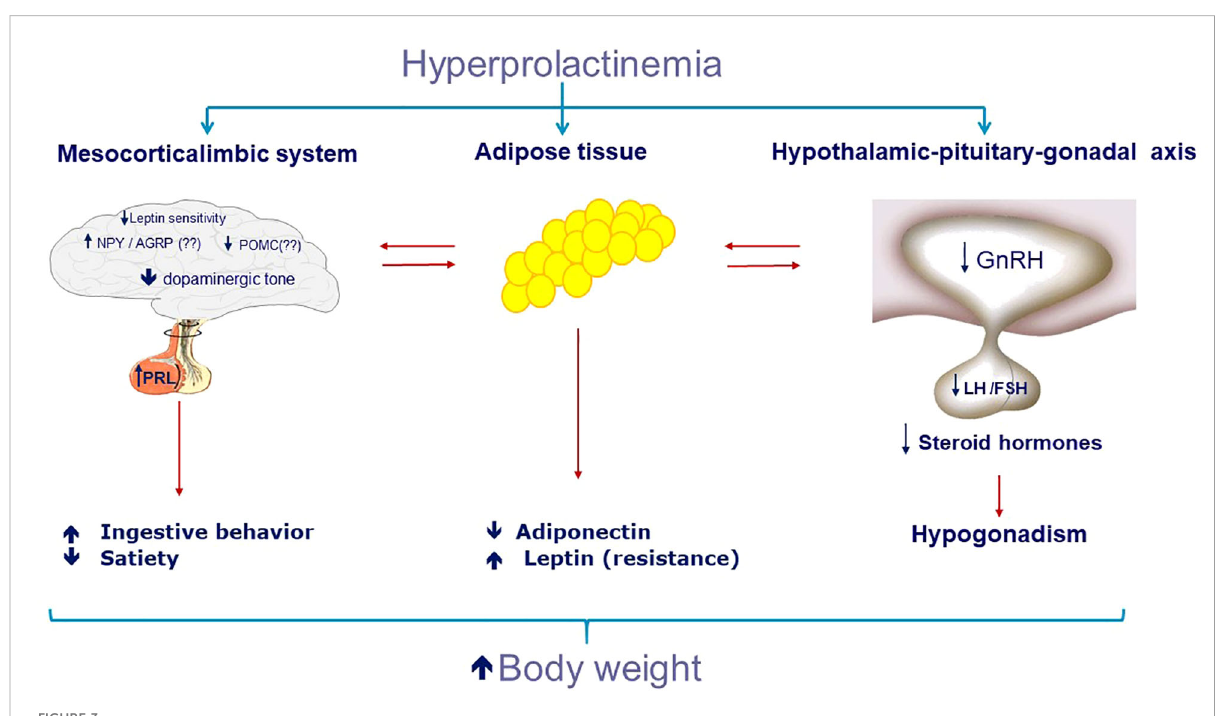
FIGURE 3 Potential role of hyperprolactinemia on increase of body